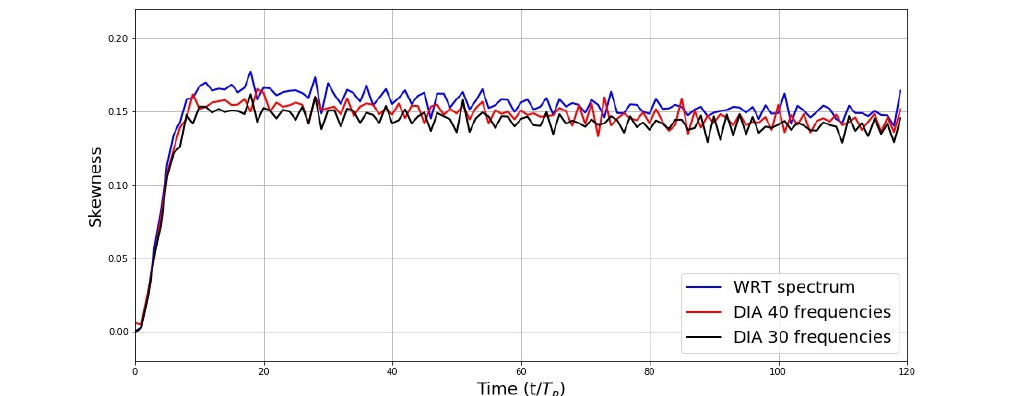
Figure 6. Time evolution of skewness for the Draupner sea state, for three different wave spectra and the use of the strong energy filter. Time is normalized by the peak wave period T p of the spectrum. The statistical parameters are estimated from an ensemble of 20 HOS simulations. The initial artificial transients are excluded from the ensemble averages as they are the result of a ramping function applied to the HOS equations to smoothly activate nonlinearities.